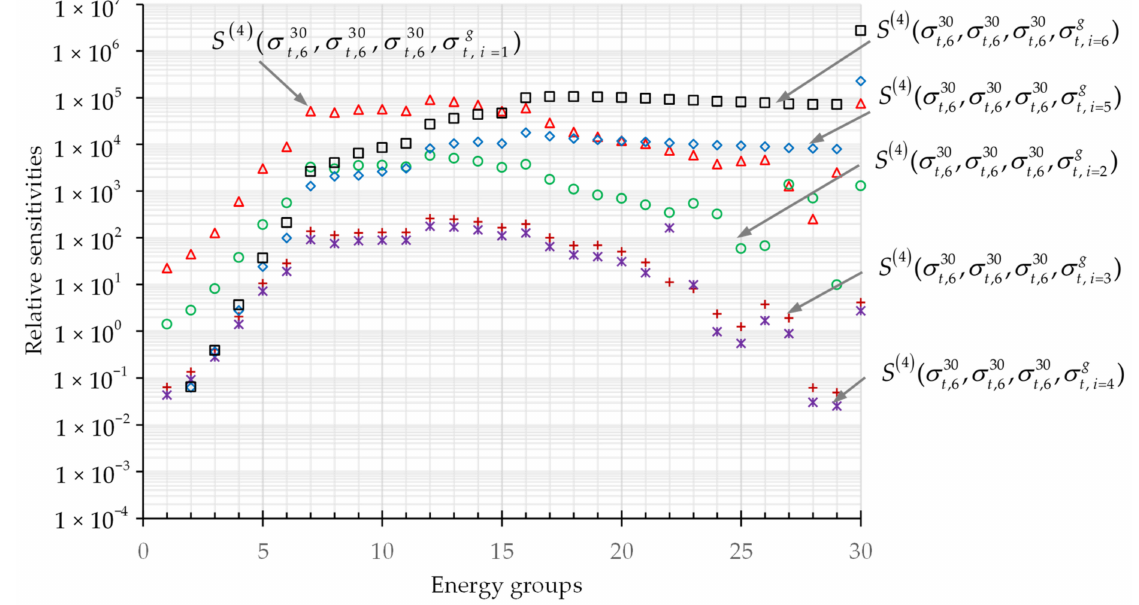
(cid:16) (cid:17) σ 30 , i = 1, . . . ,6; g = 1, . . . , σ 30 , σ 30 , σ g t ,6 t ,6 t ,6 t , i